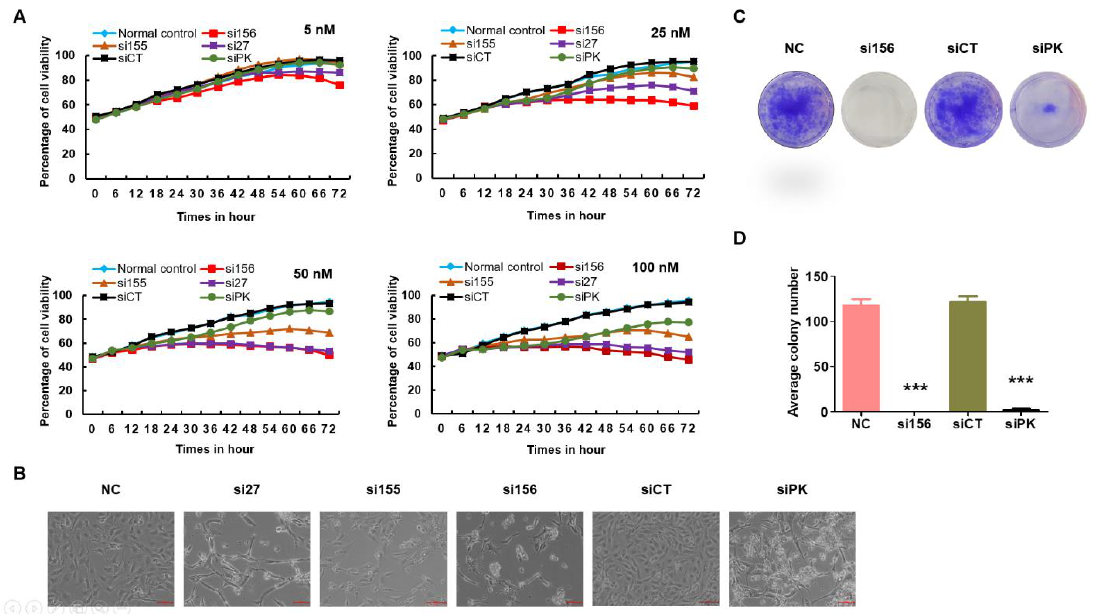
Figure 3. Consequences of PKM2 knockdown to morphology, survival, and colony formation ability of 786-O cells. ( A ) Evaluation of the effect of PKM2 knockdown on viability (determined using IncuCyte ZOOM™ live cell imaging system) of kidney cancer 786-O cells following treatment with indicated siRNAs at concentrations ranging from 5 to 100 nM for 72 h. At a concentration of 100 nM for 72 h, si156 significantly reduced the survival of 786-O cells as compared with other groups. ( B ) Morphology of untransfected and transfected 786-O cells captured at 100× magnification. Morphological changes were prominent after PKM2 knockdown as compared with normal and negative control cells. ( C ) Representative photographs of colony formation assay of 786-O cells transfected with indicated PKM2 siRNAs in six-well plates captured at 100× magnification. All cell colonies were visually recorded and counted under a light microscope. No differences in colony number were observed between normal and negative control cells as compared with si156-, si155-, and si27-transfected cells. Knockdown of PKM1 and PKM2 by siPK reduced the colony number. ( D ) Quantitative analysis of colony number. Representative data of three independent experiments are shown. One-way ANOVA was used to compare means of different groups. Differences between means were considered significant at p < 0.05 using Tukey’s multiple comparison test; *** p < 0.001 as compared with normal control cells. si27, si155, and si156: experimental siRNAs targeting PKM2 mRNA; siPK: commercially available siRNA targeting both PKM1 and PKM2 mRNAs (positive control); and siCT (siControl): siRNA targeting the firefly luciferase gene (negative control).